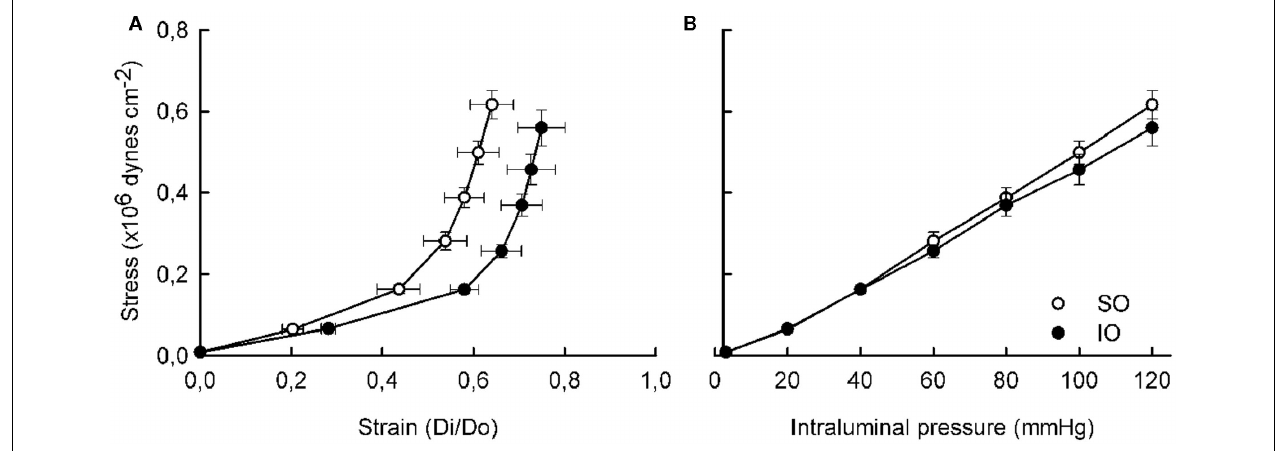
FIGURE 2 | Effect of mesenteric I/R on mechanical properties from fully relaxed rat mesenteric resistance arteries. (A) Stress–strain (Di/Do). (B) Wall stress-intraluminal pressure. Do, internal diameter at 3mmHg; Di, observed internal diameter from a given intravascular pressure.Values are the mean ± SEM of n = 9–10.